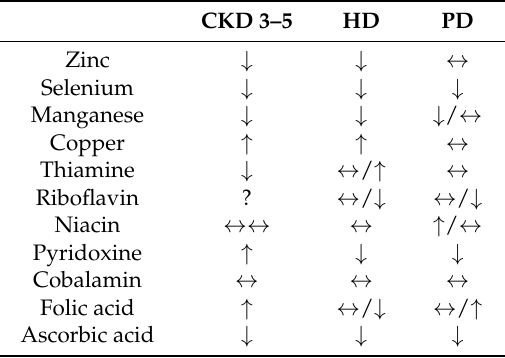
Summary of vitamin and microelement plasma or serum levels in chronic kidney disease (CKD) and different modalities of renal replacement therapy [2,23–26]. HD: hemodialysis; PD peritoneal dialysis. CKD